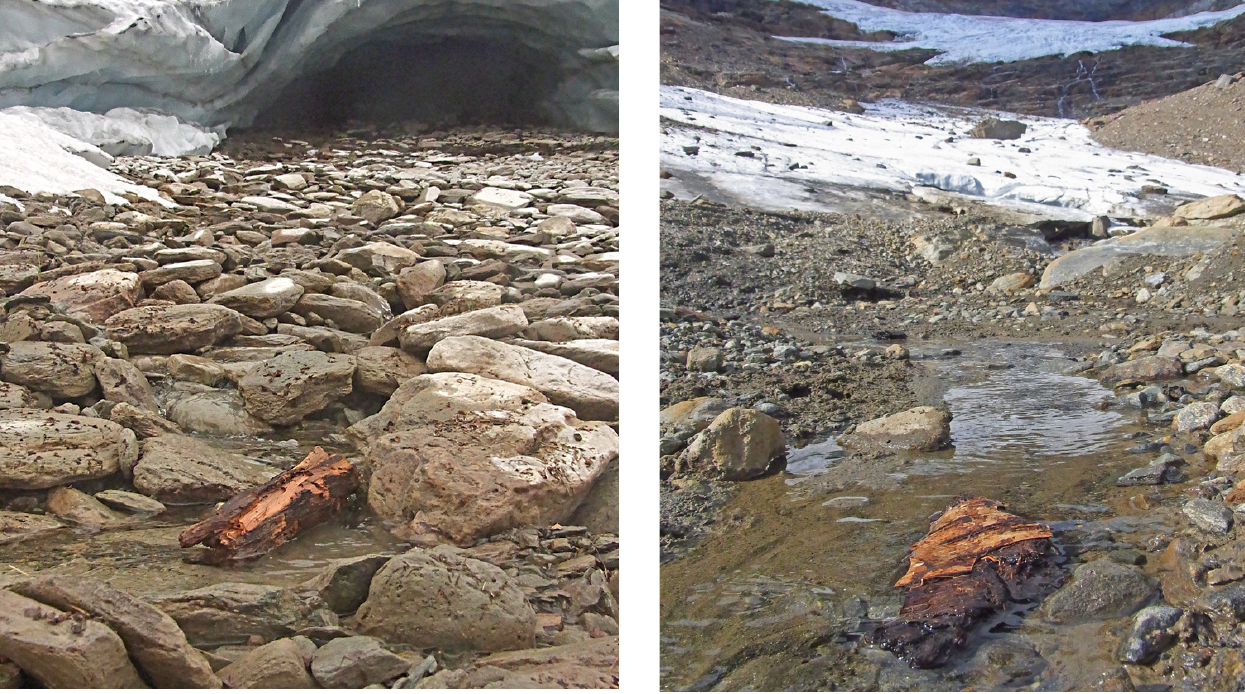
Figure 19: Tärnaglaciären (6). Large piece of a birch stem with bark fragments, exposed in the main drainage stream. 6280 cal. yr BP